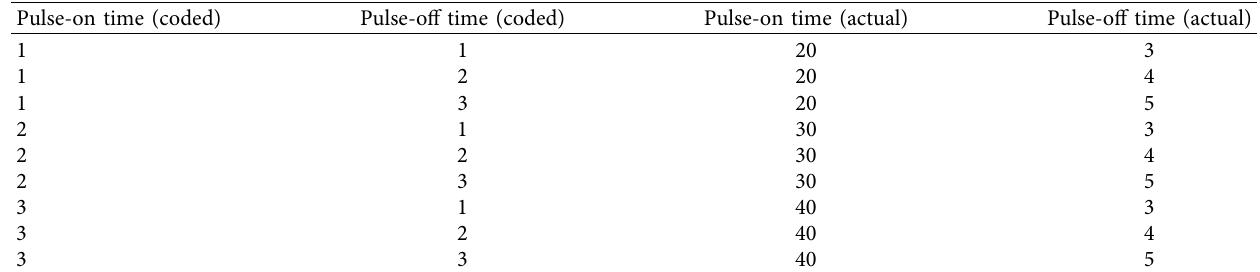
Table 5: L9 orthogonal array for EDM